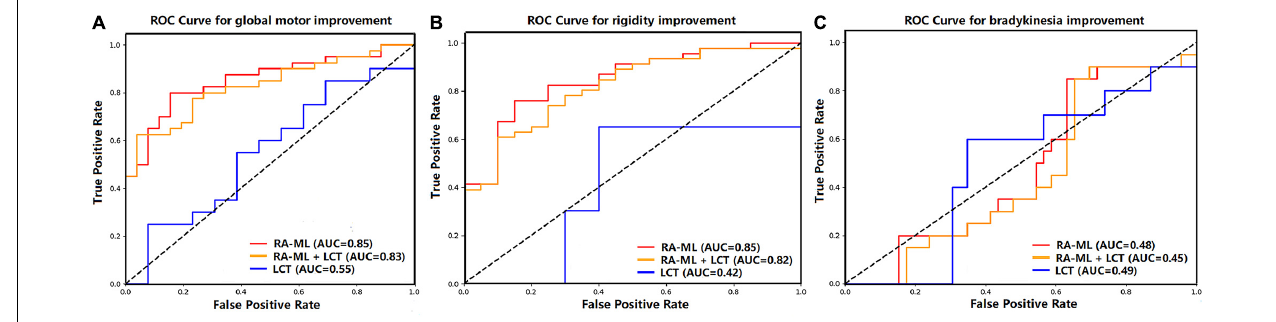
FIGURE 2 | Graph shows receiver operating characteristic curves of the three models predictive of global motor (A) , rigidity (B) , and bradykinesia (C) improvements after STN-DBS.